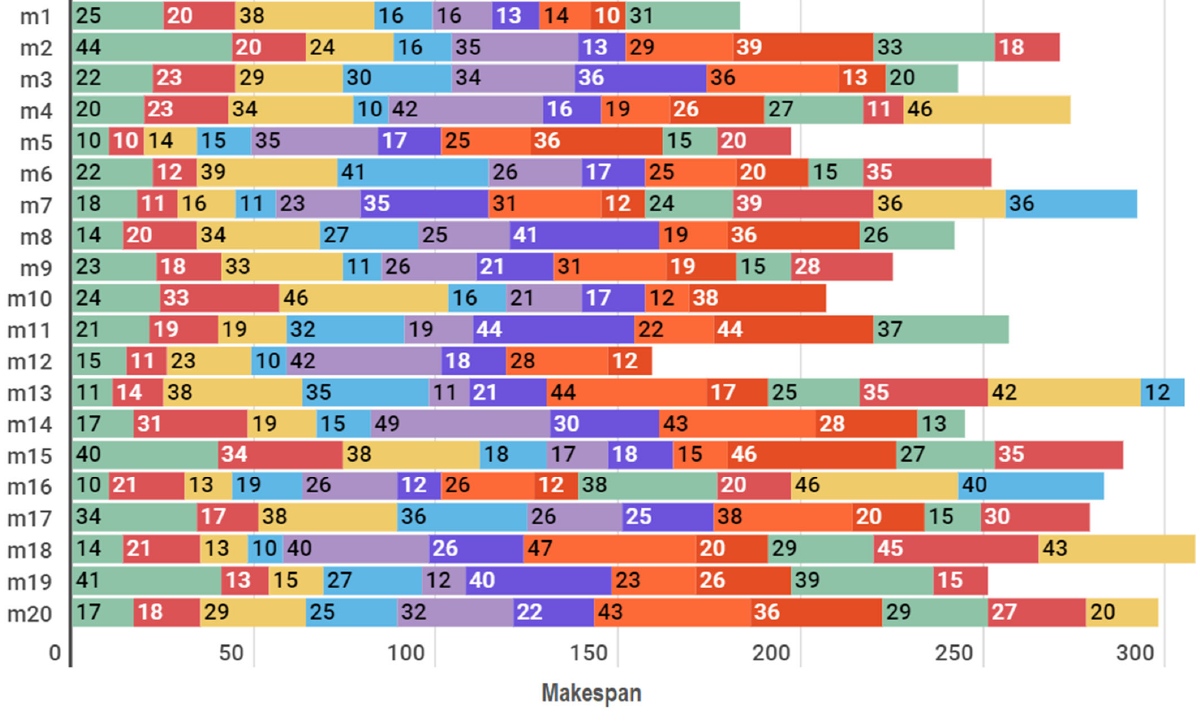
Fig. 11. Gantt chart of solution makespan in the third